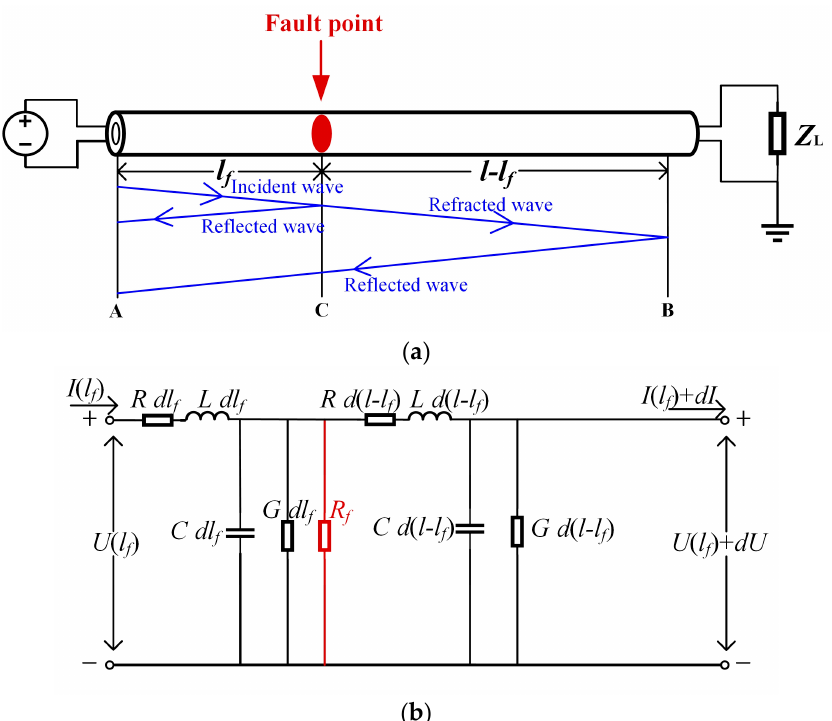
Figure 1. ( a ) High − frequency cable with fault point. ( b ) Fault cable in high − frequency equivalent circuit of distribution parameter.